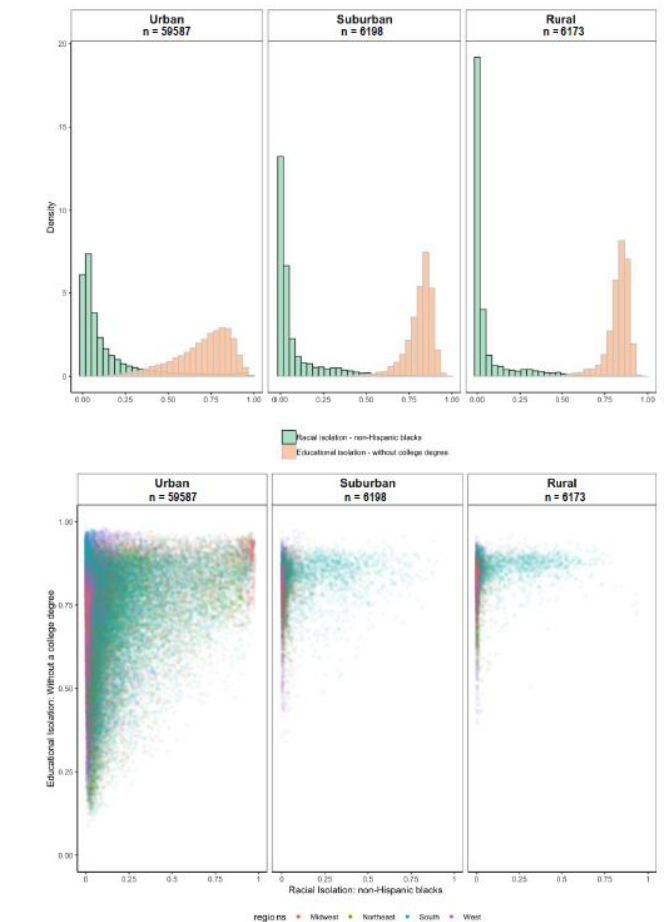
Figure 3. Distribution of RI and EI for the continental US in urban, suburban, and rural census tracts (Panel A ) and plot of EI index values versus RI index values for urban, suburban, and rural census tracts (Panel B ).